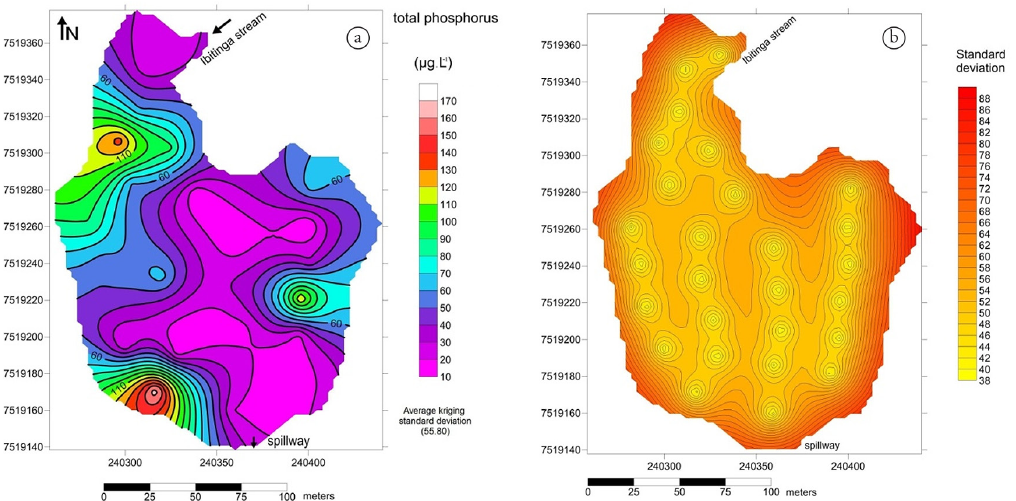
Figure 7. Estimates (a) and standard deviations (b) of total phosphorus